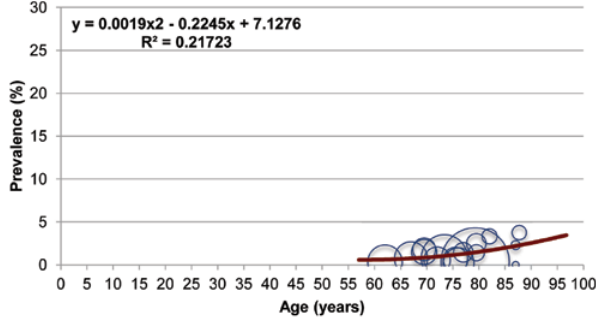
Figure 5 Age–specific prevalence of vascular dementia in Africa, with sample size underlying each data point presented by the size of each